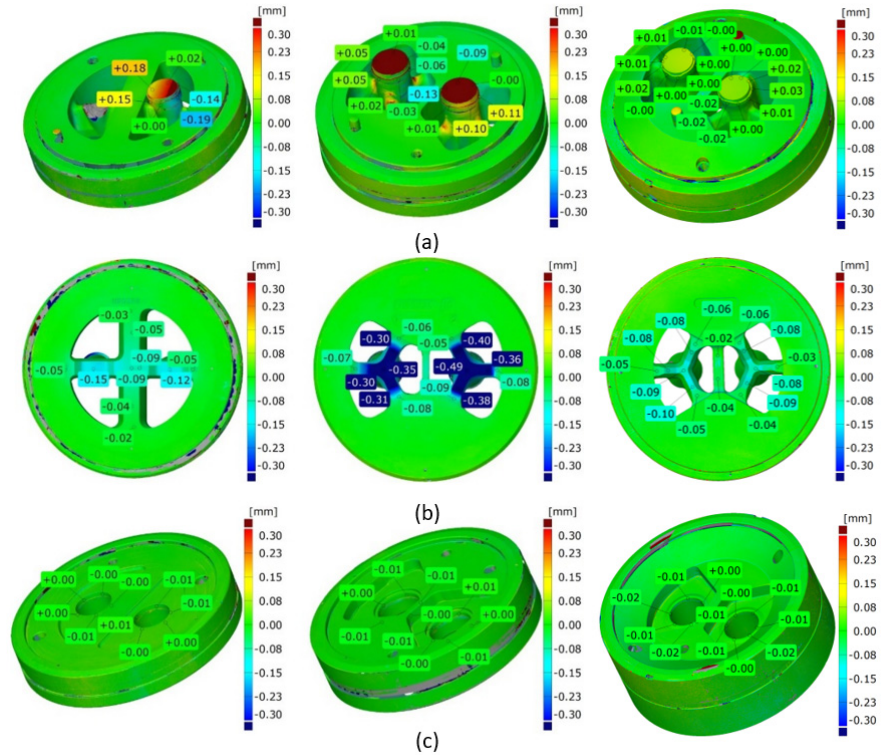
Figure 24. Results of optical scanning of the porthole dies for extrusion of tubes of Ø50 × 2 mm from 7021 alloy: die deflection for mandrels ( a ), bridges ( b ) and inserts ( c )—die 1 (on the left), die 2 (in the middle) and die 3 (on the right).